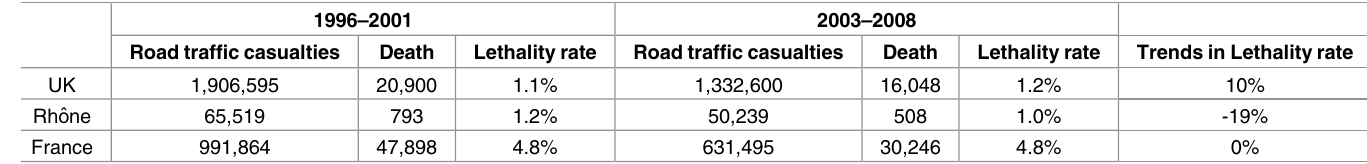
Table 8. Comparison of epidemics of RTC in United Kingdom, France and the Rhone County in the two periods